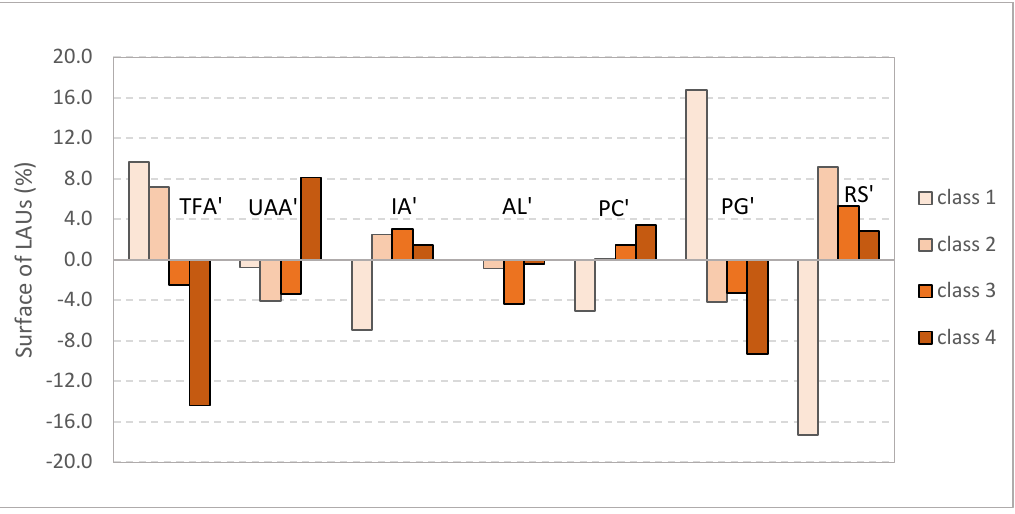
Figure 8. Difference in percentage of LAUs’ surface between the values of the two census dates (C2 value ‒ C1 value).